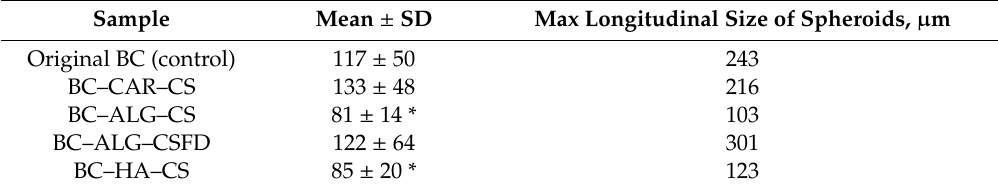
Table 6. The average and maximal longitudinal size of multipotent mesenchymal stem cell spheroids formed on di ff erent sca ff olds at three days after seeding, µ m. Reliability of the changes in comparison with the reference group (Mann–Whitney): * p <